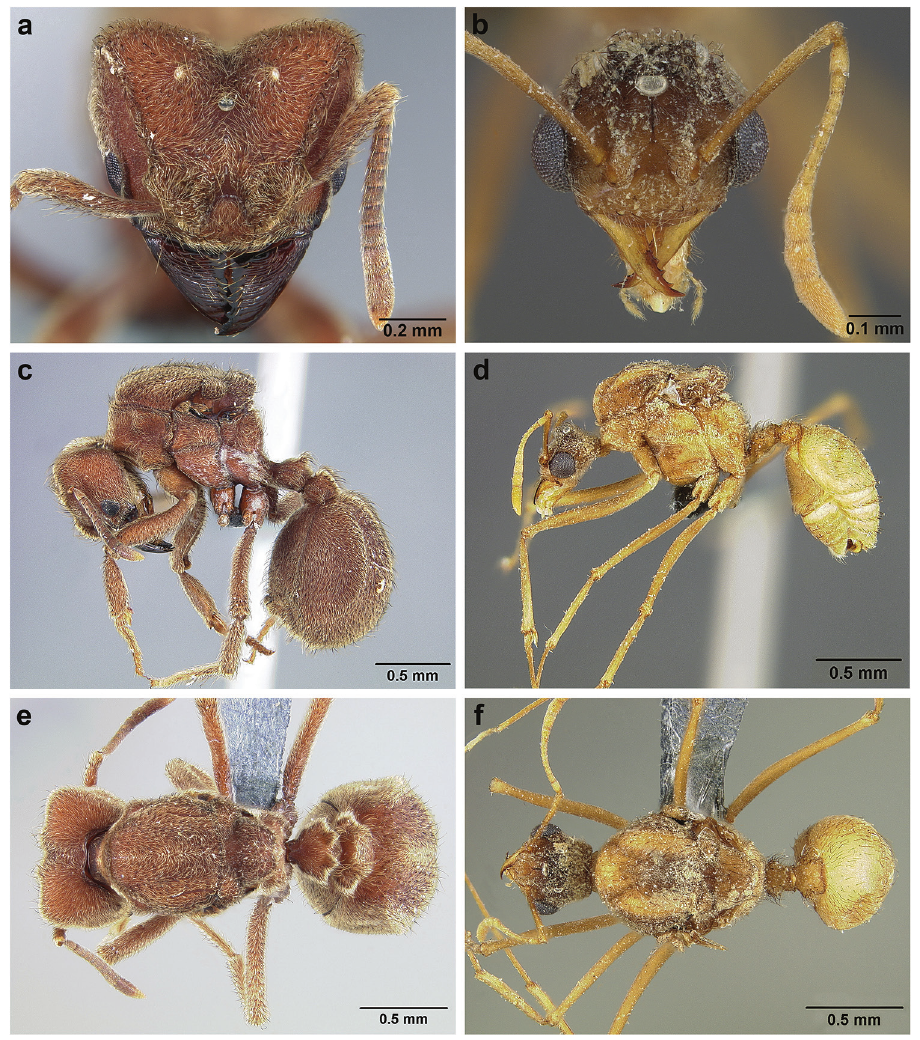
Figure 39. S. mayri queen and male; head, lateral profile, and dorsal view. Queen (USN- MENT01126007) ( a, c, e ). Male (USNMENT01126022) ( b, d, f posteriorly with shallow longitudinal impressions on each side. Parapsidal lines thin, slightly curved. In dorsal view scutellum short, narrowing posteriorly, posterior notch shallow, sometimes continuing into median impression that divides scutellum in two lateral parts. Propodeal denticles reduced, low. Metasoma. Petiole in frontodorsal view with two pointed, distinct dorsal denticles, and two smaller, lateral denticles. Postpetiole with two dorsal and two lateral short, low carinae, sometimes reduced to small denticles. First gastral tergite with lateral carinae strongly developed, dorsal carinae weak, anteromedian groove distinct.